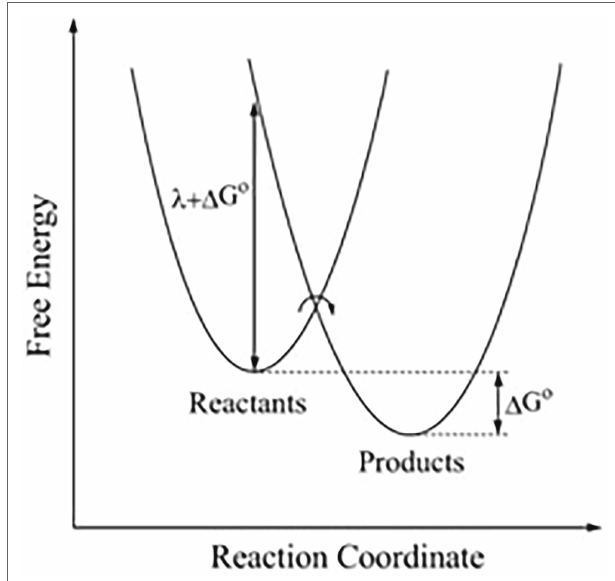
FIGURE 2 | Free energy curves for reactant and product states showing the definition of ∆ 0 G and λ . These two parabolas are plotted vs. the reaction coordinate that describes the progress of the reaction. The transition state occurs at the intersection of the two parabolas, as also in Figure 1 in Marcus and Sutin (1985). For simplicity of presentation, some symbols and the labeling of work terms are omitted